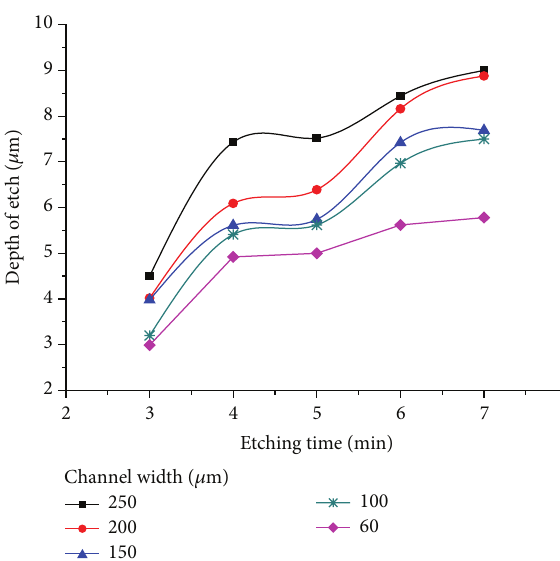
Figure 10: Effect of etching time on depth of etch for different channel